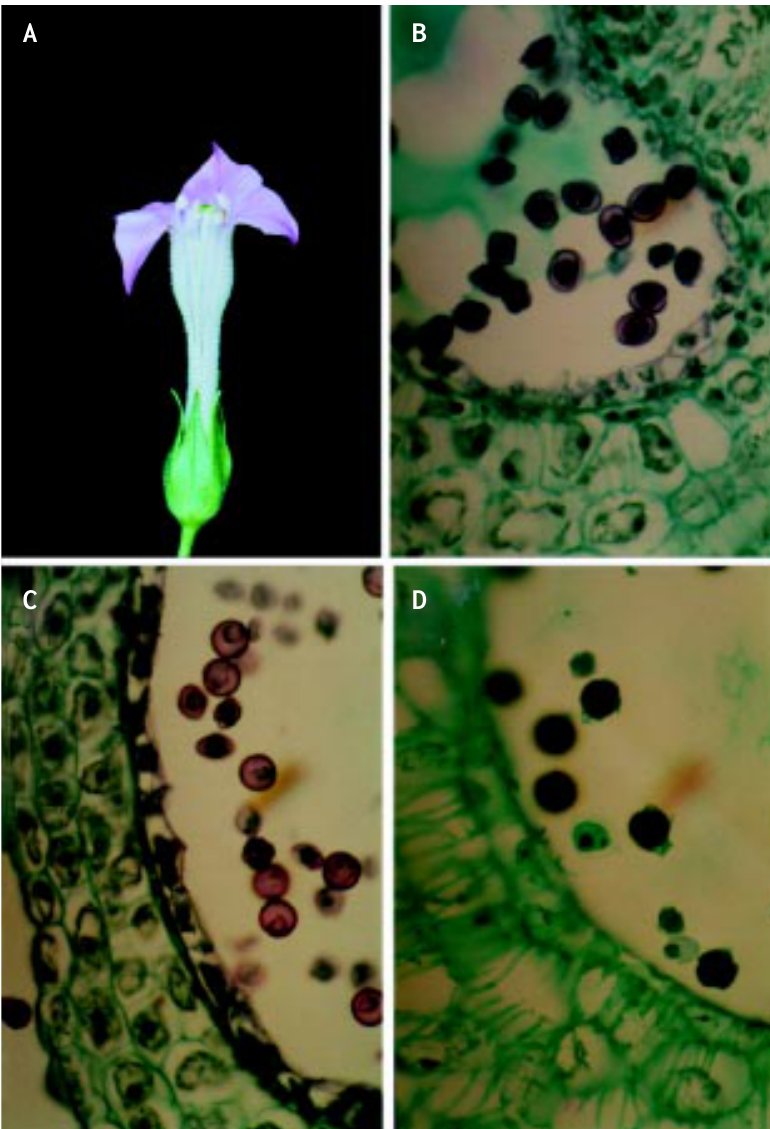
Figure 8 - Floral morphology of the transgenic tobacco clone RN4 . A , Flower at anthesis, phenotypically similar to a non- transformed flower. B-D , Anther locula at different developmental stages. Early uninucleate microspores (stage 2), meiosis complete and microspores have separated from tetrad ( B ); late uninucleate microspores (stage 5) ( C ); binucleate pollen grains (stage 10) ( D ). Magnification for B-D,